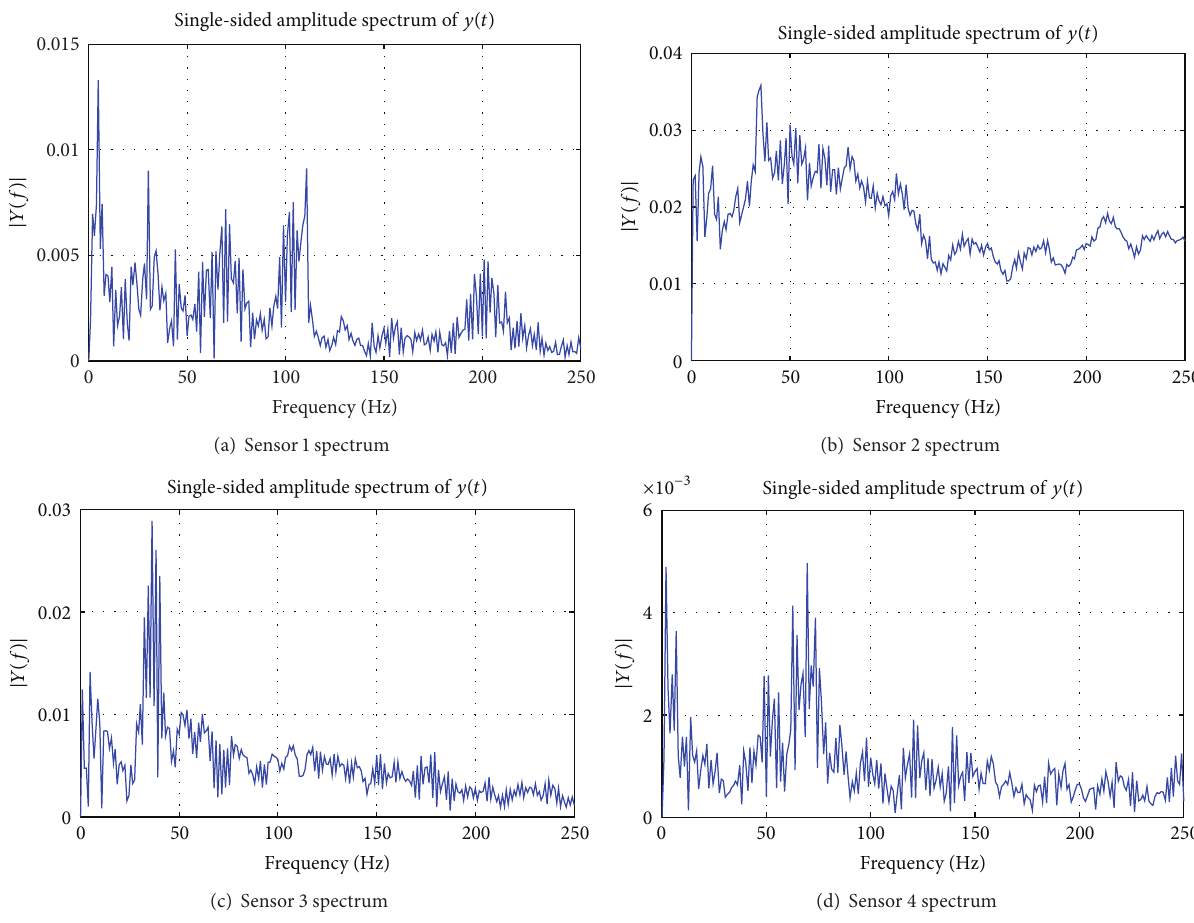
(b) Sensor 2 spectrum